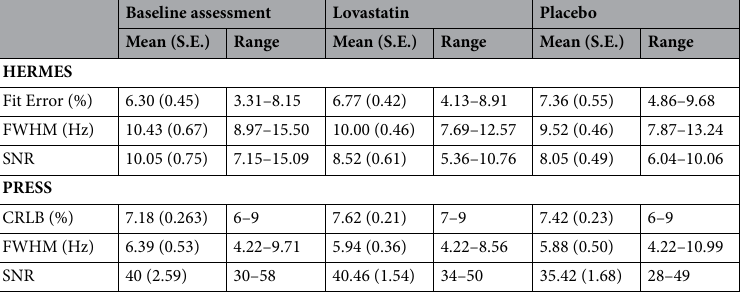
Table 2. MRS data quality parameters. S.E. standard error, FWHM full width at half maximum, SNR signal- to-noise ratio, CRLB Cramér-Rao Lower